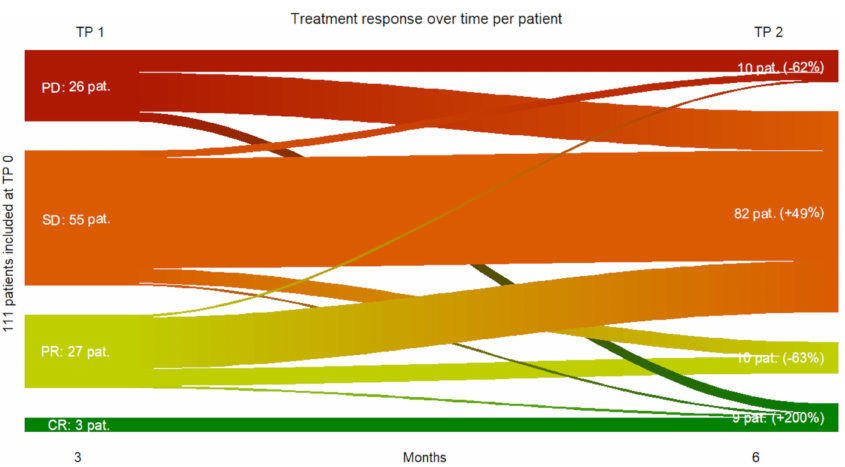
Figure 6. Sankey plot of treatment response over time from TP 0 to TP 2 per patient. In total 111 metastatic melanoma patients were included at TP 0. From the top to the bottom: Treatment response per patient. Progressive Disease PD in red; Stable Disease SD in orange; Partial Response PR in lime-green; Complete Response CR in green. From left to right: Time point baseline TP 0; three months after initiating immunotherapy TP 1; six months after initiation immunotherapy TP